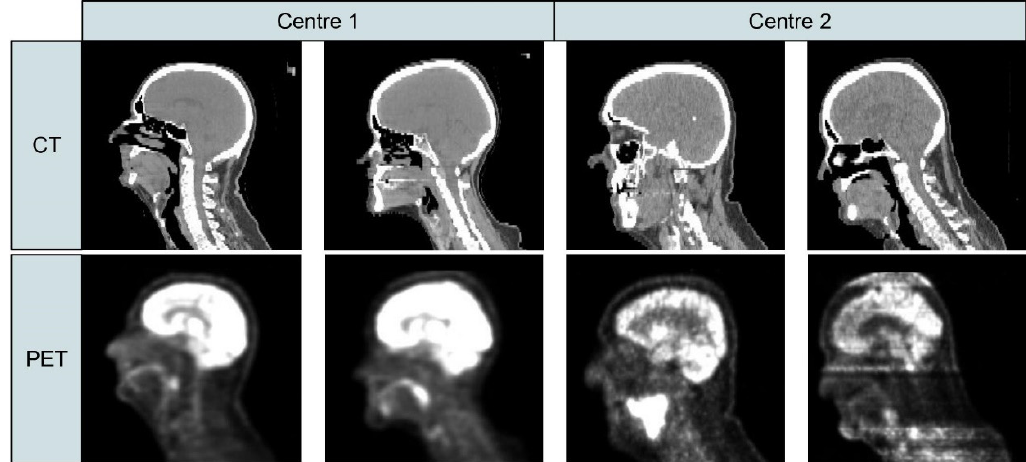
Figure 1. PET and CT slices obtained from two different centers (Center 1 = Centre Hospitalier Universitaire de Sherbrooke, Sherbrooke, Canada and Center 2 = Hôpital Maisonneuve-Rosemont, Montréal, Canada). The top row shows CT images while the bottom row shows PET images. The four columns indicate four different patients. Adapted from [23].